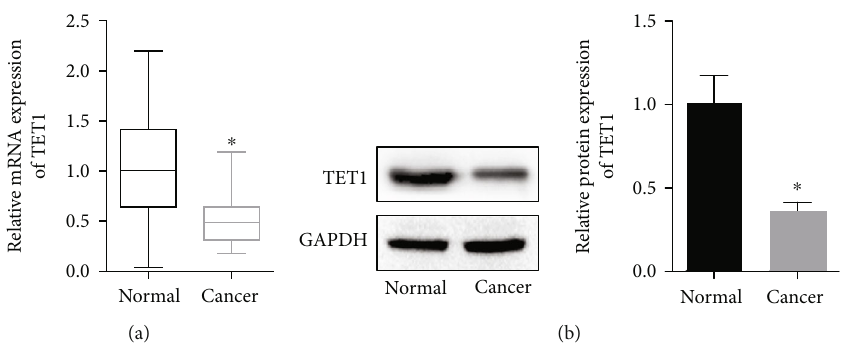
Figure 1: TET1 was downregulated in glioma specimens. (a) RT-qPCR was performed to detect the RNA level of TET1 in tumor tissues and the adjacent normal tissue of patients with glioma. (b) Western blot was adopted to analyses the expression of TET1. ∗ P < 0 : 05